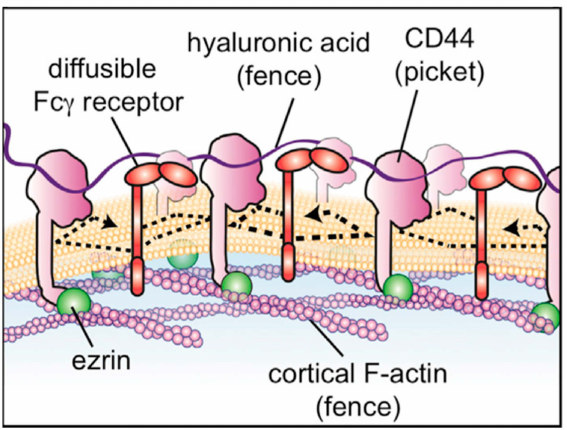
Figure 8. ”Picket fence” on the cell membrane created by a single molecule of extracellular hyaluronan participating in polyvalent binding with multiple transmembrane CD44 molecules. Reprinted with permission from Ref. [43]. Copyright 2018